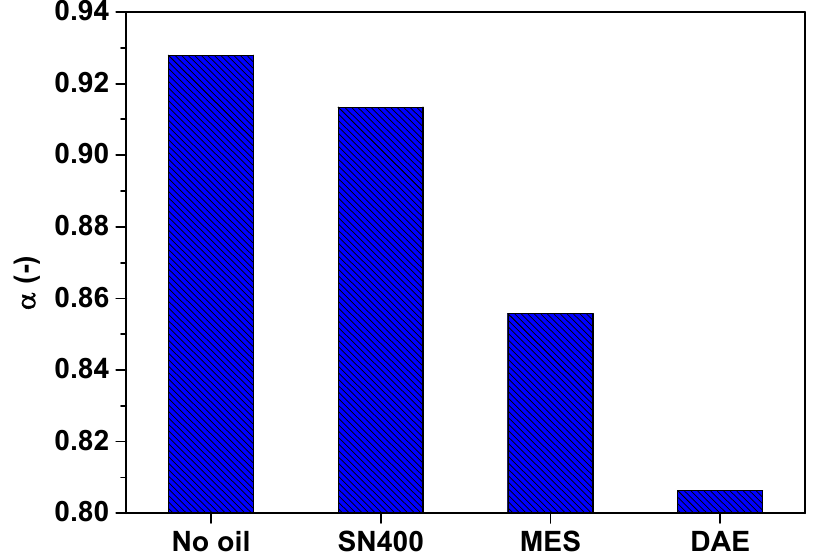
Figure 10. Broadness parameter α of the SBR samples determined by means of simultaneous mechanical and dielectric measurements at 24 °C under a static force of 10 N.